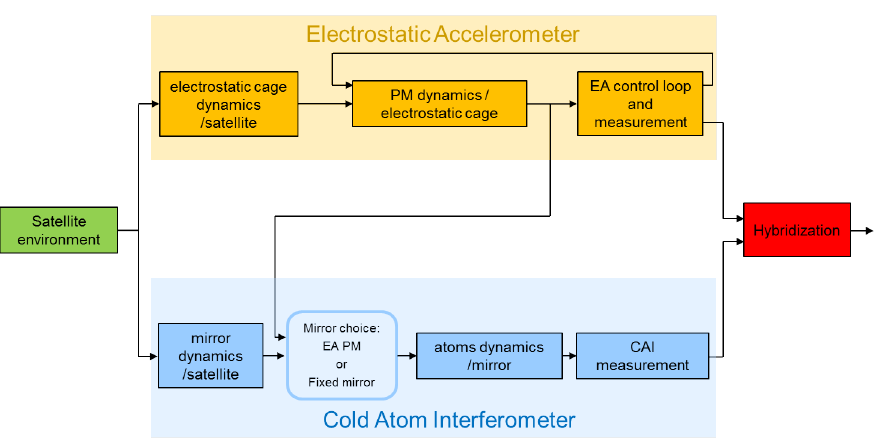
Figure 9. Global view of the software simulator for the in-orbit operation of the hybrid